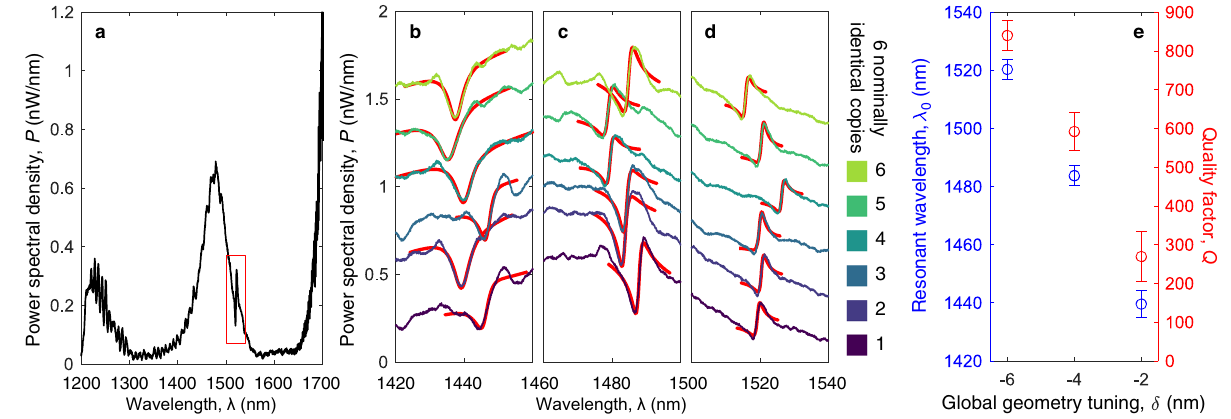
Fig. 2 | Optical far- fi eld characterization of dielectric bowtie cavities. a Broadbandspectrumofacavitywith δ = − 6nm.Thecavitymodeinterfereswitha background mode yielding a Fano resonance centered at λ ~1520nm, highlighted by the red box. b – d Spectra for six nominally identical devices for each tuning δ ={ − 2, − 4, − 6}nm. The spectrum of each copy is offset incrementally by